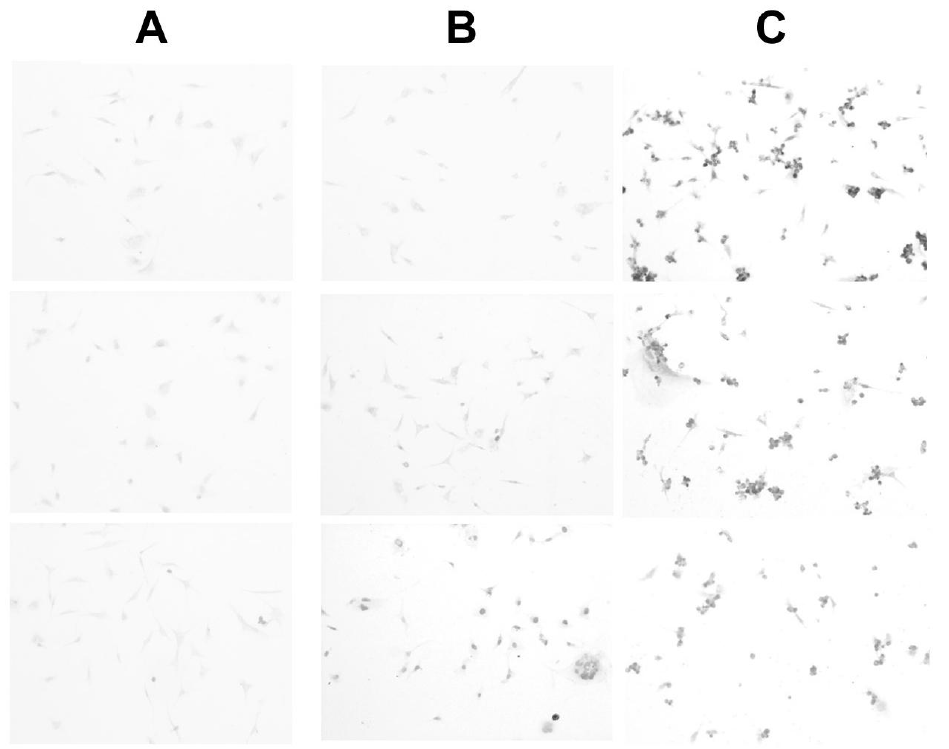
FIGURE 2. Panel of micrographs showing ApopTag labeling of MDA-MB231 cells cultured in control conditions (A) and in the presence of 1-nM PTHrP (38-94)-amide (B,C), using oligo A (one-base dT overhang- end detection; B) and oligo B (blunt-end detection; C). Massive positive reaction was obtained only in C. Microscopic magnification: 20 